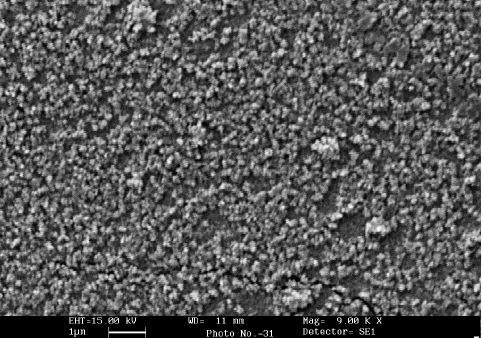
Figure 3 . Scanning electron micrograph of thin film of CoPc on to the glass substrate deposited at 303K.